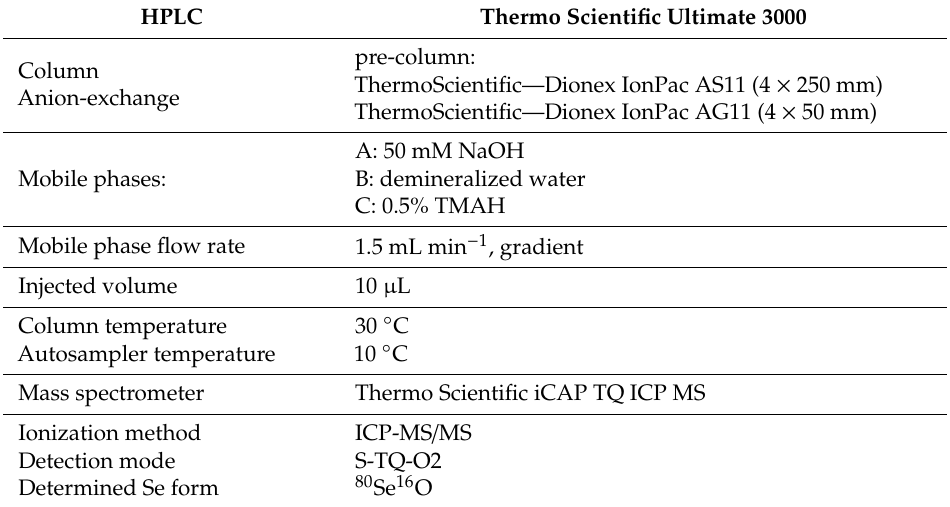
Table 2. Instrumental operating conditions for high performance liquid chromatography combined with inductively coupled plasma mass spectrometry (HPLC–ICP-MS)